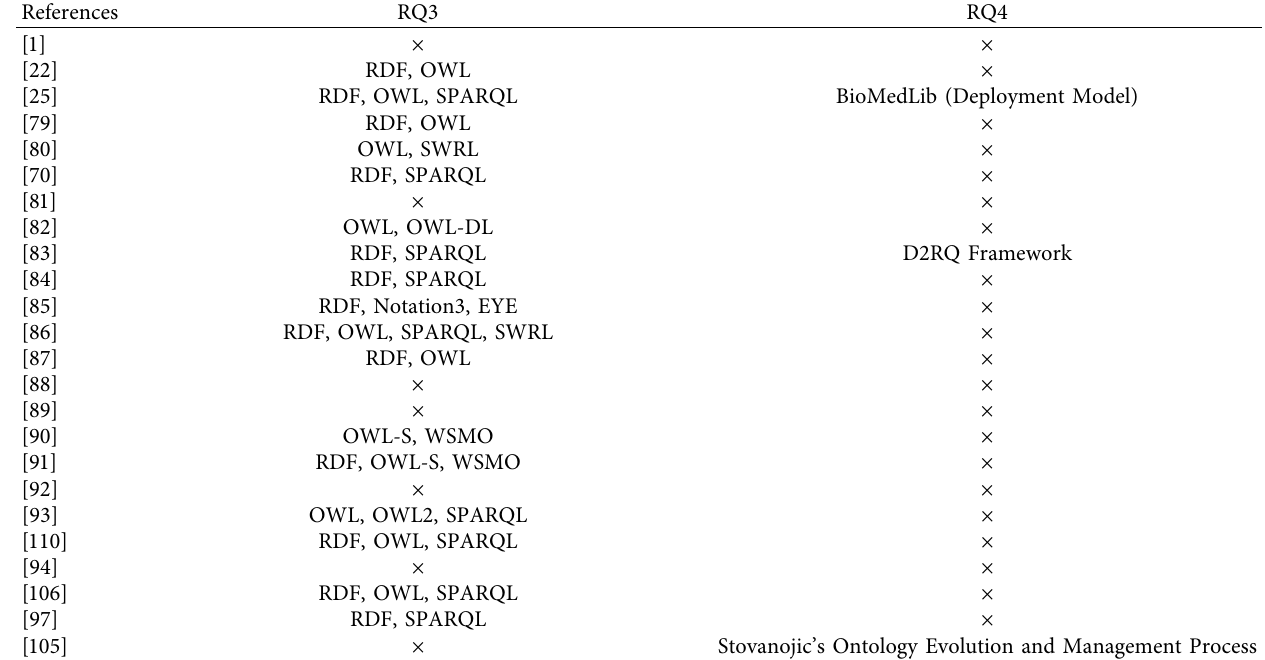
Table 8: Summary of Semantic Web technologies used in information